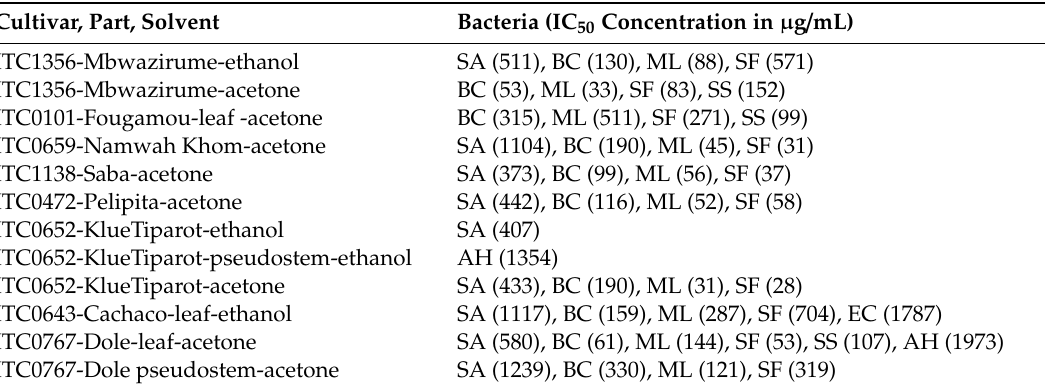
Table 5. IC 50 of selected